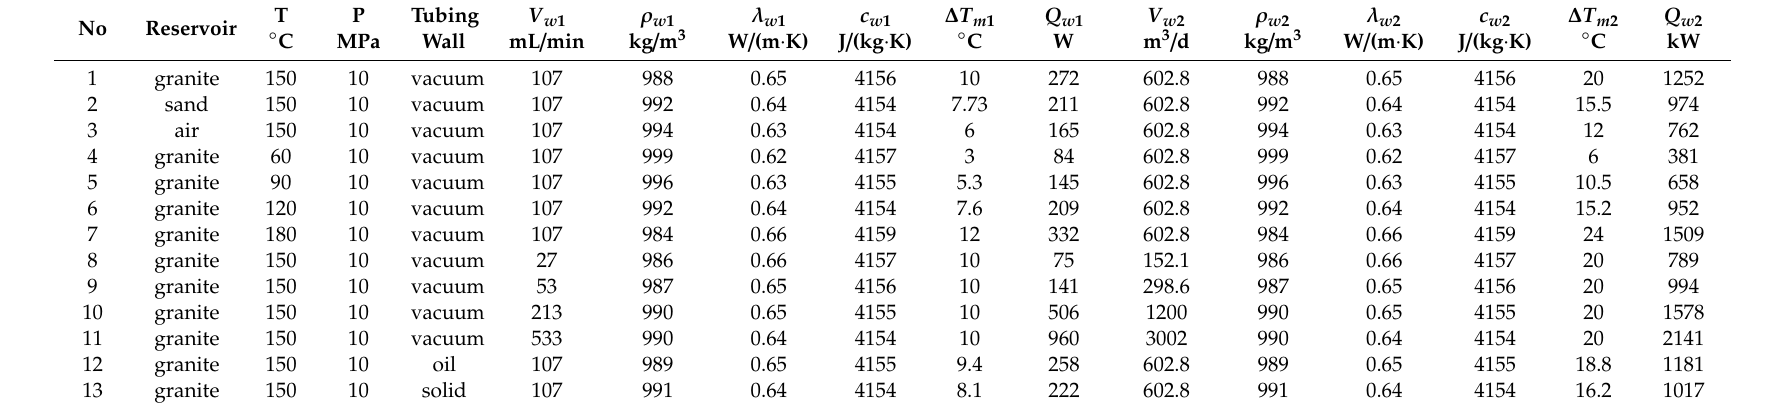
Table 5. The estimated heat mining rate in a 2000 m horizontal well